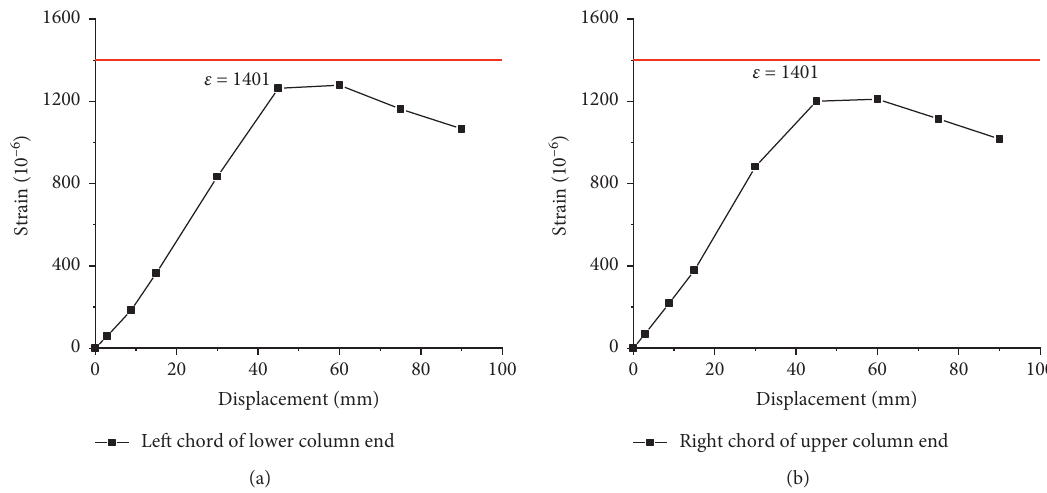
Figure 16: Strain of angle steel of column end chord: (a) angle steel of left chord of lower column end and (b) angle steel of right chord of upper column